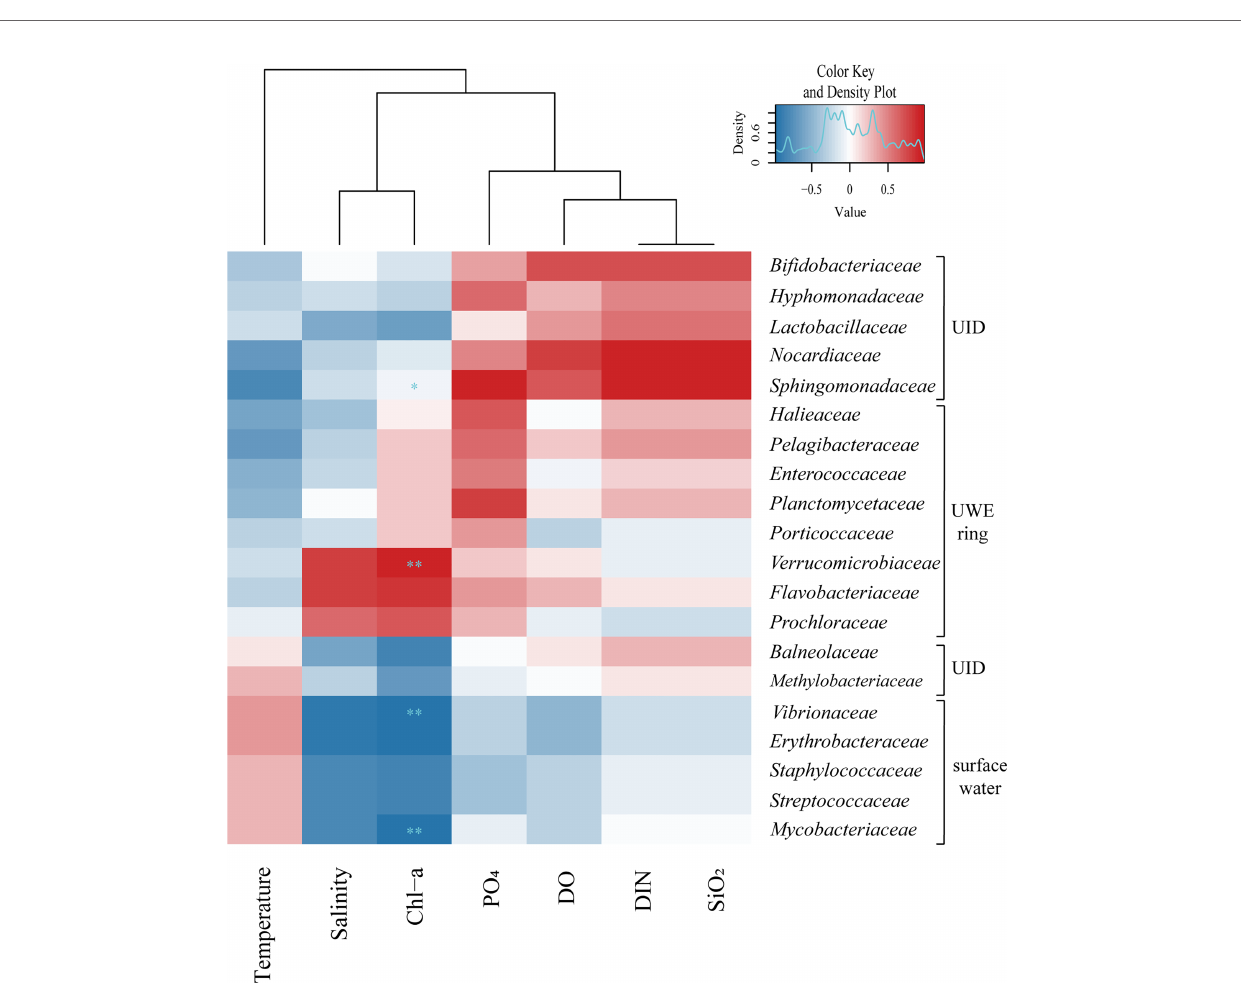
FIGURE 8 | The 20 genera family level bacteria showed marked differences in relative abundance within three groups (i.e., UWE ring, UID, and surface water) classi fi ed as the occurrence of Ulleung warm eddy (UWE) during winter. Hierarchical heatmap using Spearman ’ s correlation coef fi cient revealed interrelation between the relative abundance of bacterial community (at the family level) and the physical and biogeochemical factors. The variations of surface bacterial community composition with 20 genera family level showed strong correlation to characteristics of environmental parameters created by physical eddy circulation. The symbols of * and ** indicate p value less than 0.05 and 0.01,